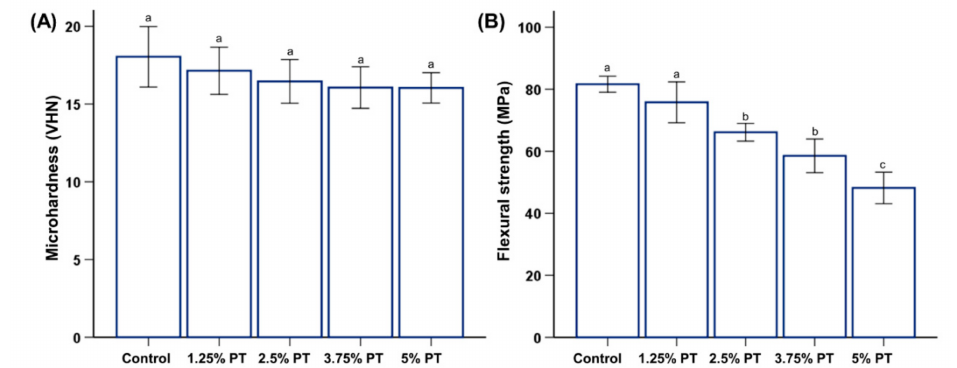
Figure 2. Comparison of microhardness ( A ) and flexural strength ( B ) among di ff erent groups of PMMA samples. Same lowercase alphabetical letters above the bar graph indicate there are no significant di ff erences between the groups (e.g., there are no di ff erence between group with ‘a’ and another group with ‘a’ above the bar) ( p > 0.05). Di ff erence in lowercase alphabetical letters above the bar graph indicate significant di ff erences between the groups (e.g., there are di ff erences between the group with ‘a’ and the group with ‘b’.) ( p < 0.05).